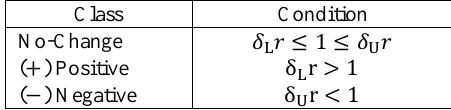
Table 3. Decision rules for three-class